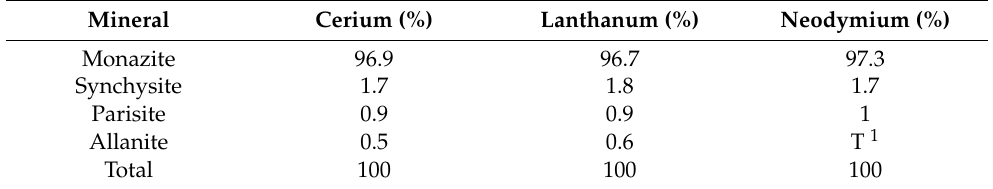
Table 1. Distribution of major REEs within the dominant REE minerals in the flotation feed as revealed by